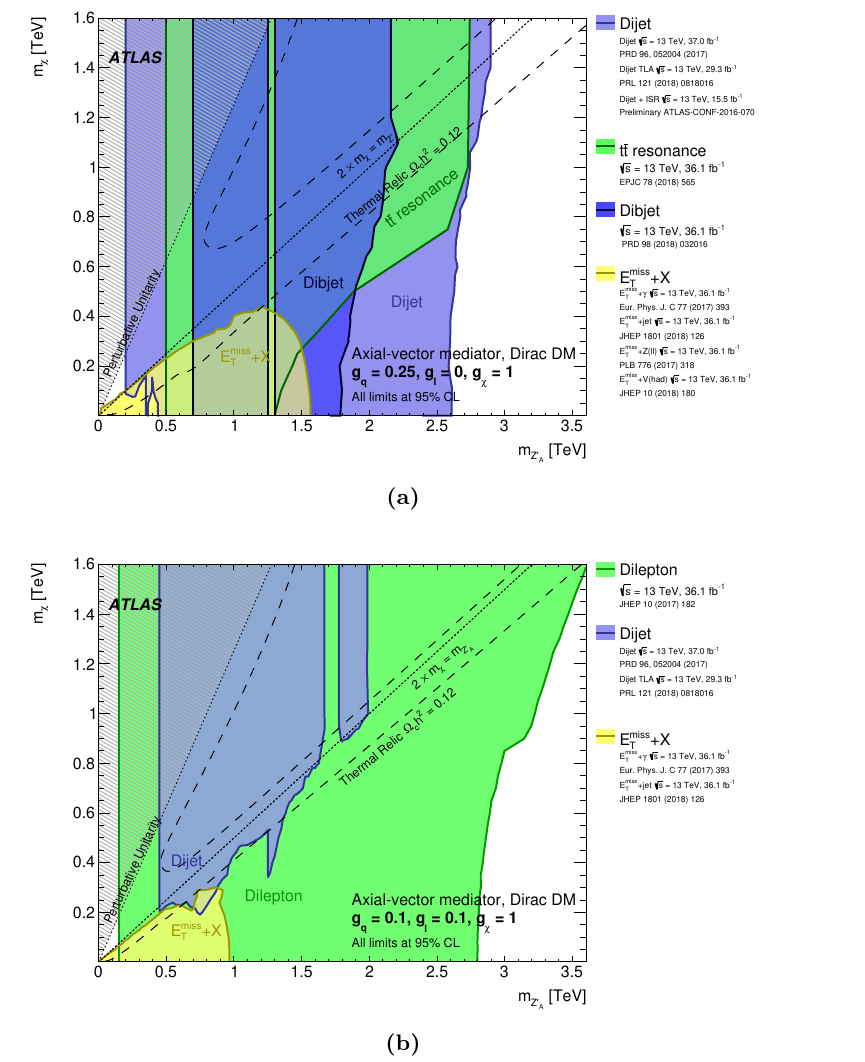
Figure 12. Regions in a (mediator-mass, DM-mass) plane excluded at 95% CL by visible and invisible searches, for leptophobic (a) or leptophilic (b) axial-vector mediator simpli(cid:12)ed models described in section 2.1.1. The exclusions are computed for a DM coupling g (cid:31) , quark coupling g q , universal to all (cid:13)avours, and lepton coupling g ‘ as indicated in each case. Dashed curves labelled \thermal relic" correspond to combinations of DM and mediator mass values that are consistent with a DM density of (cid:10) h 2 = 0 : 12 and a standard thermal history, as computed in MadDM [77, 204]. Between the two curves, annihilation processes described by the simpli(cid:12)ed model deplete (cid:10) h 2 to below 0 : 12. A dotted line indicates the kinematic threshold where the mediator can decay on- shell into DM. Excluded regions that are in tension with the perturbative unitary considerations of ref. [205] are indicated by shading in the upper left corner.